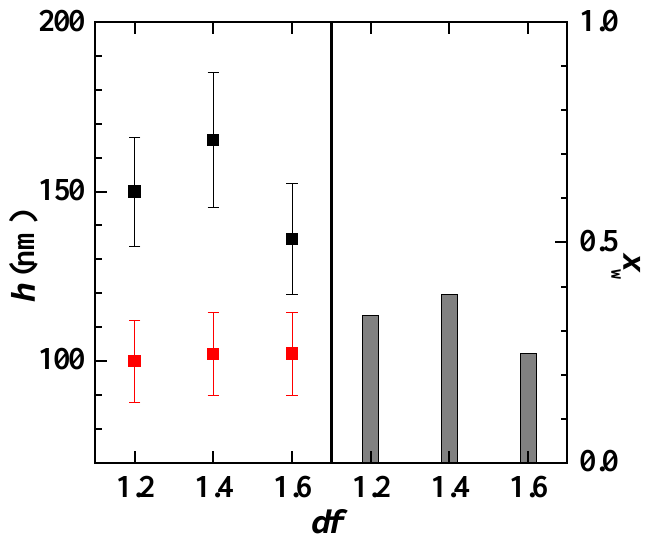
Figure 15. Comparison of the acoustic ( ■ ) and optical ( ■ ) thicknesses for the deposition of layers of the experimental model mixture, and water content of the deposited layers (bar charts), for samples at different values of the dilution factor.